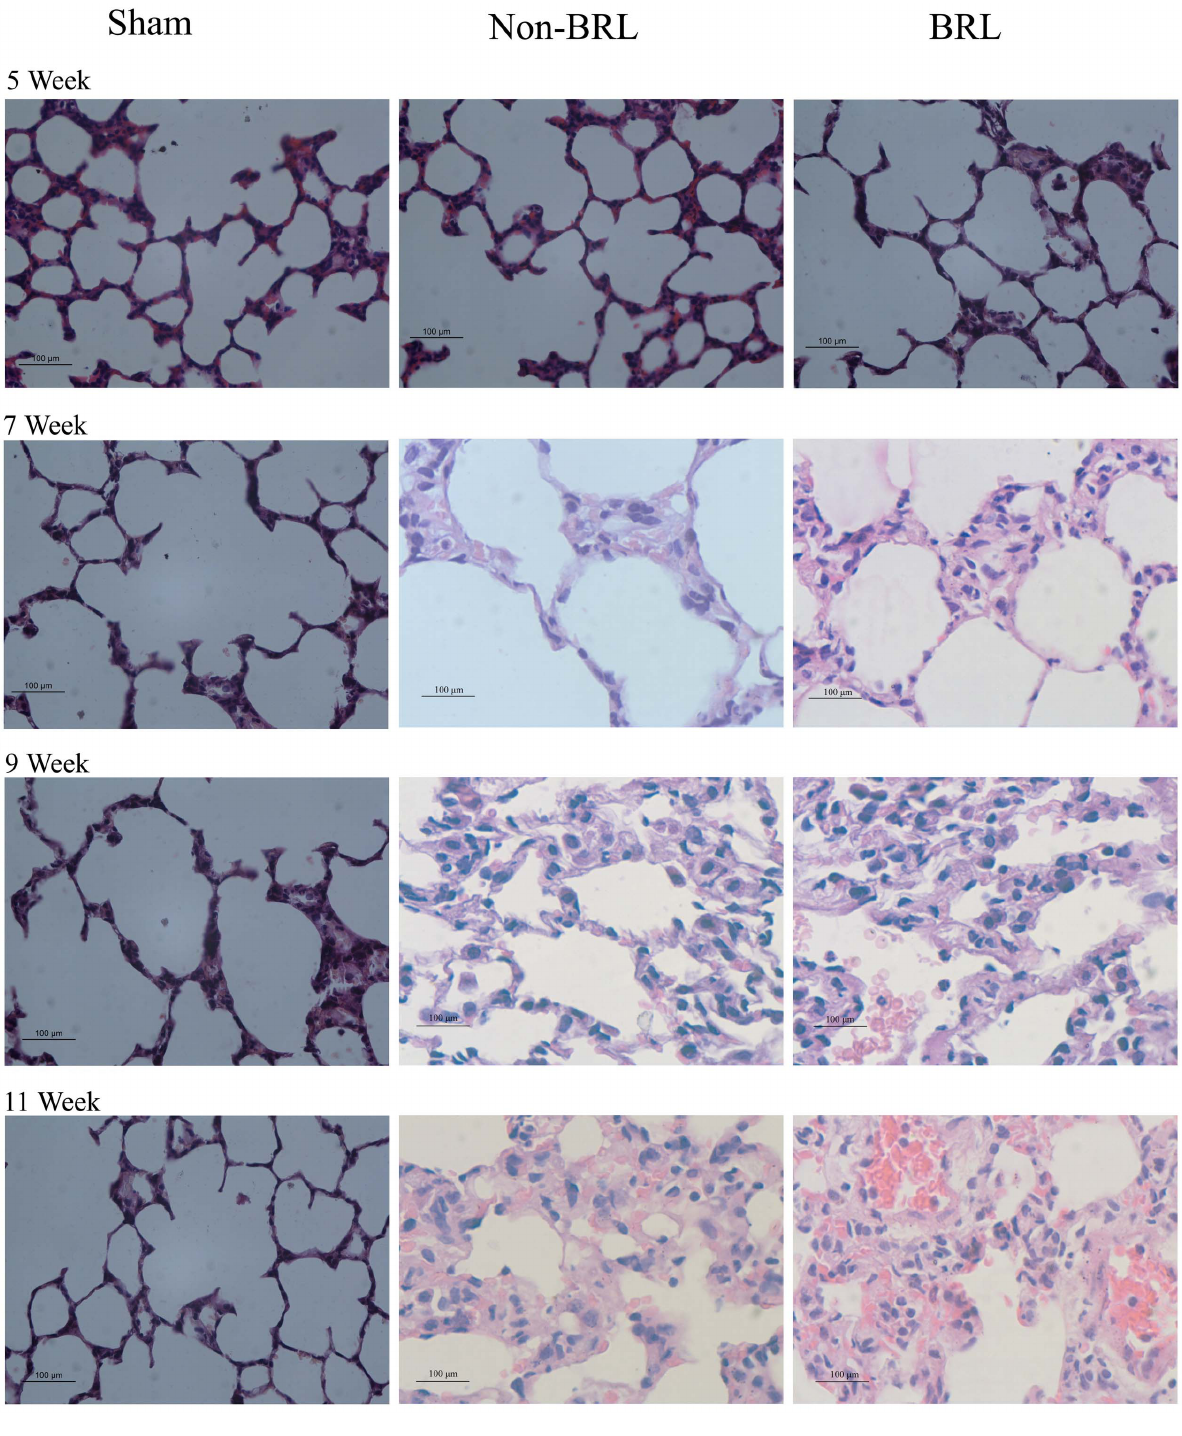
Figure 2. Lung histopathology at different times and in different groups. The lung tissues were observed with a Brightfield microscope under 40 6 magnification (Olympus BX 51, Japan). During the 2–5 th week after operation, no significant difference in alveolar space, lung interstice and peri-alveolar blood vessels from BRL group, non-BRL group or Sham group was observed. However, during the 5–7 th week after operation, the peri-alveolar blood vessels in the BRL group revealed slight dilation and blood stasis, and then during the 7–11 th week after operation, the lung lesions was gradually characterized by interstitial edema, acinar cell vacuolization, and infiltration of inflammatory and congestion edema in the BRL group. BRL group: HF group with b 3 -AR agonist BRL37344 injection; non-BRL: HF group without BRL37344 injection.